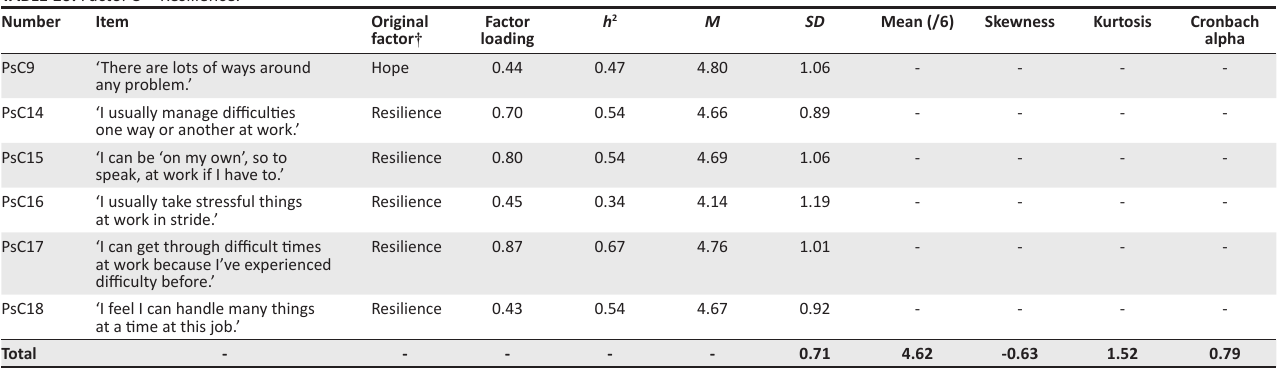
TABLE 10: Factor 3 – Resilience.